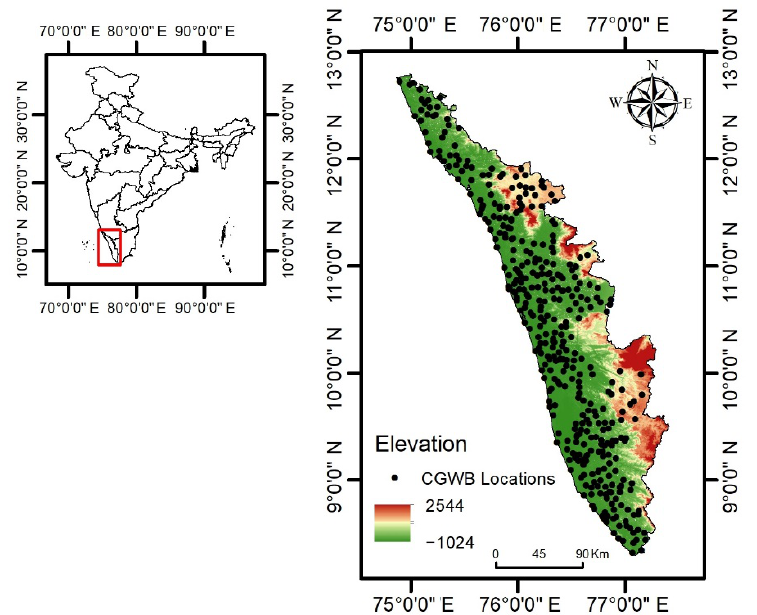
Figure 1. Kerala Map with the studied well locations on a base map of elevation.